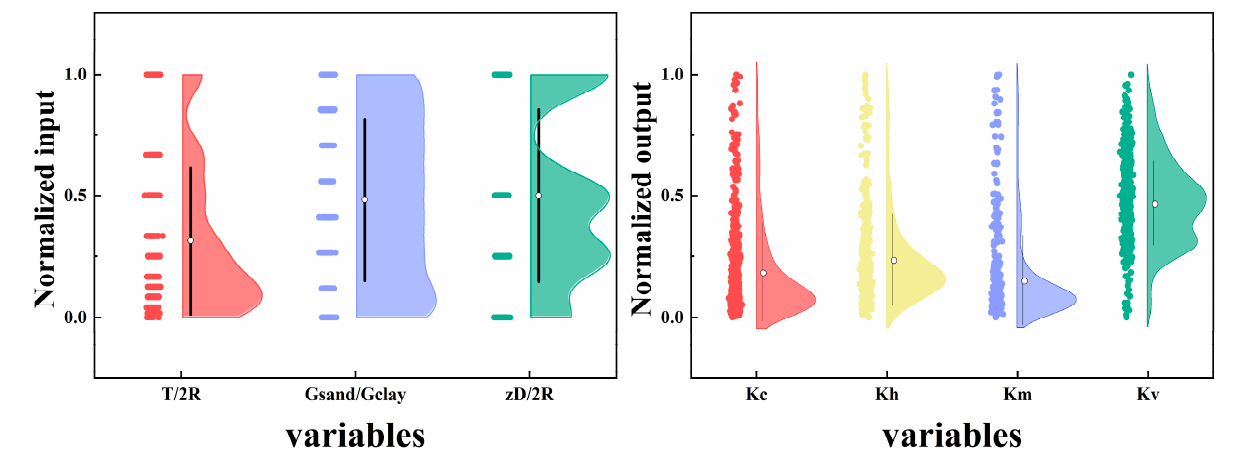
Figure 3. Data distribution of inputs and outputs.